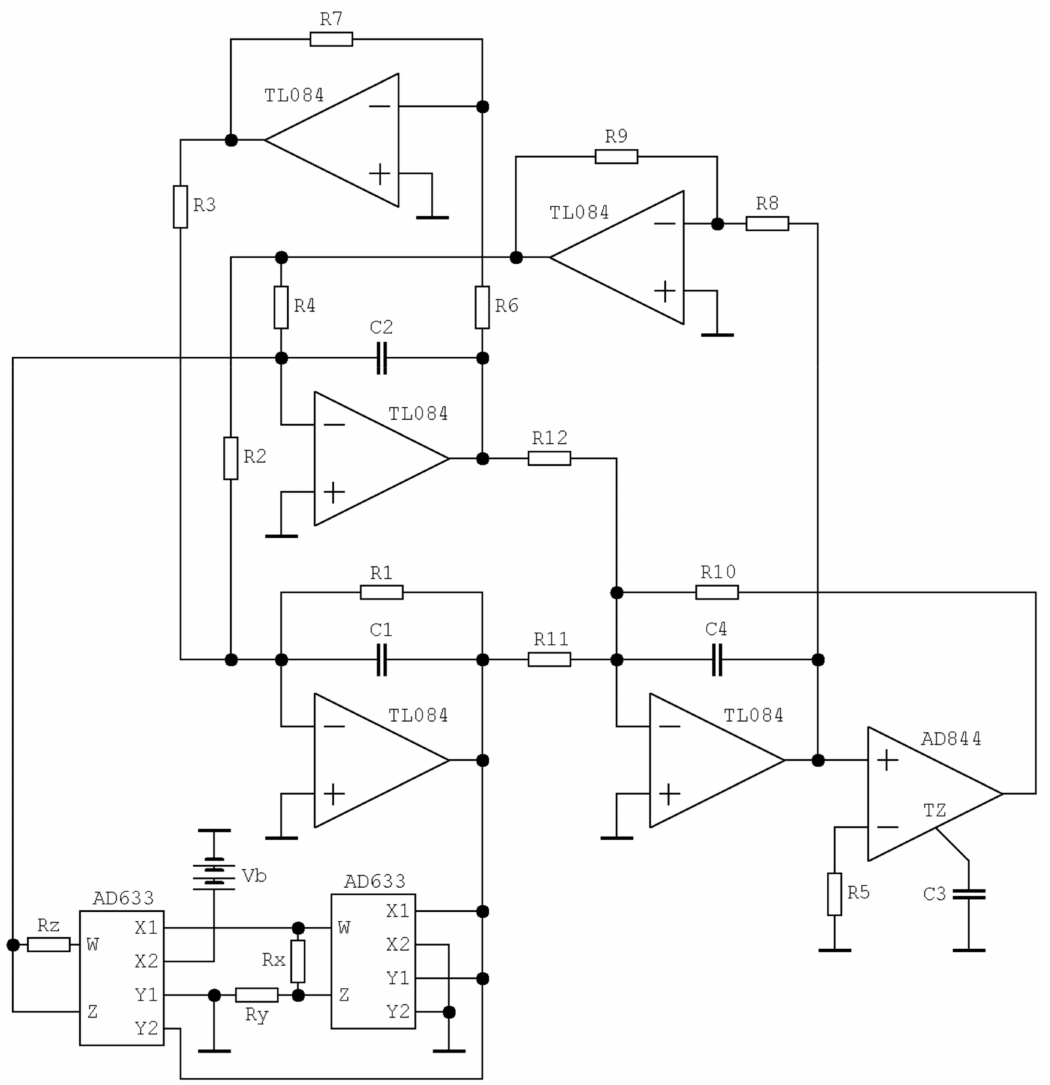
Figure 13. Circuitry implementation of chaotic Clapp oscillator based on the analog computer concept. Contains single integrated circuit AD844, five TL084, and two AD633. External DC voltage supply V b can be used to trace evolution of chaos. Individual state variables are easily accessible as voltages measured at the outputs of inverting